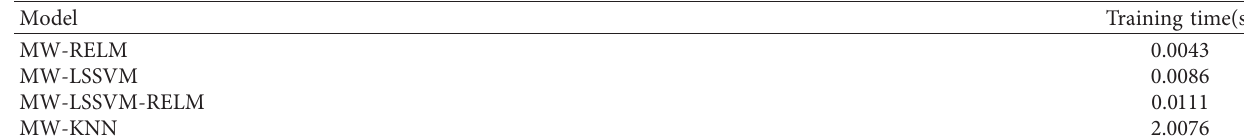
Figure 16: Switching process of different models. Table 12: Training time under deterrent soft-sensor models.